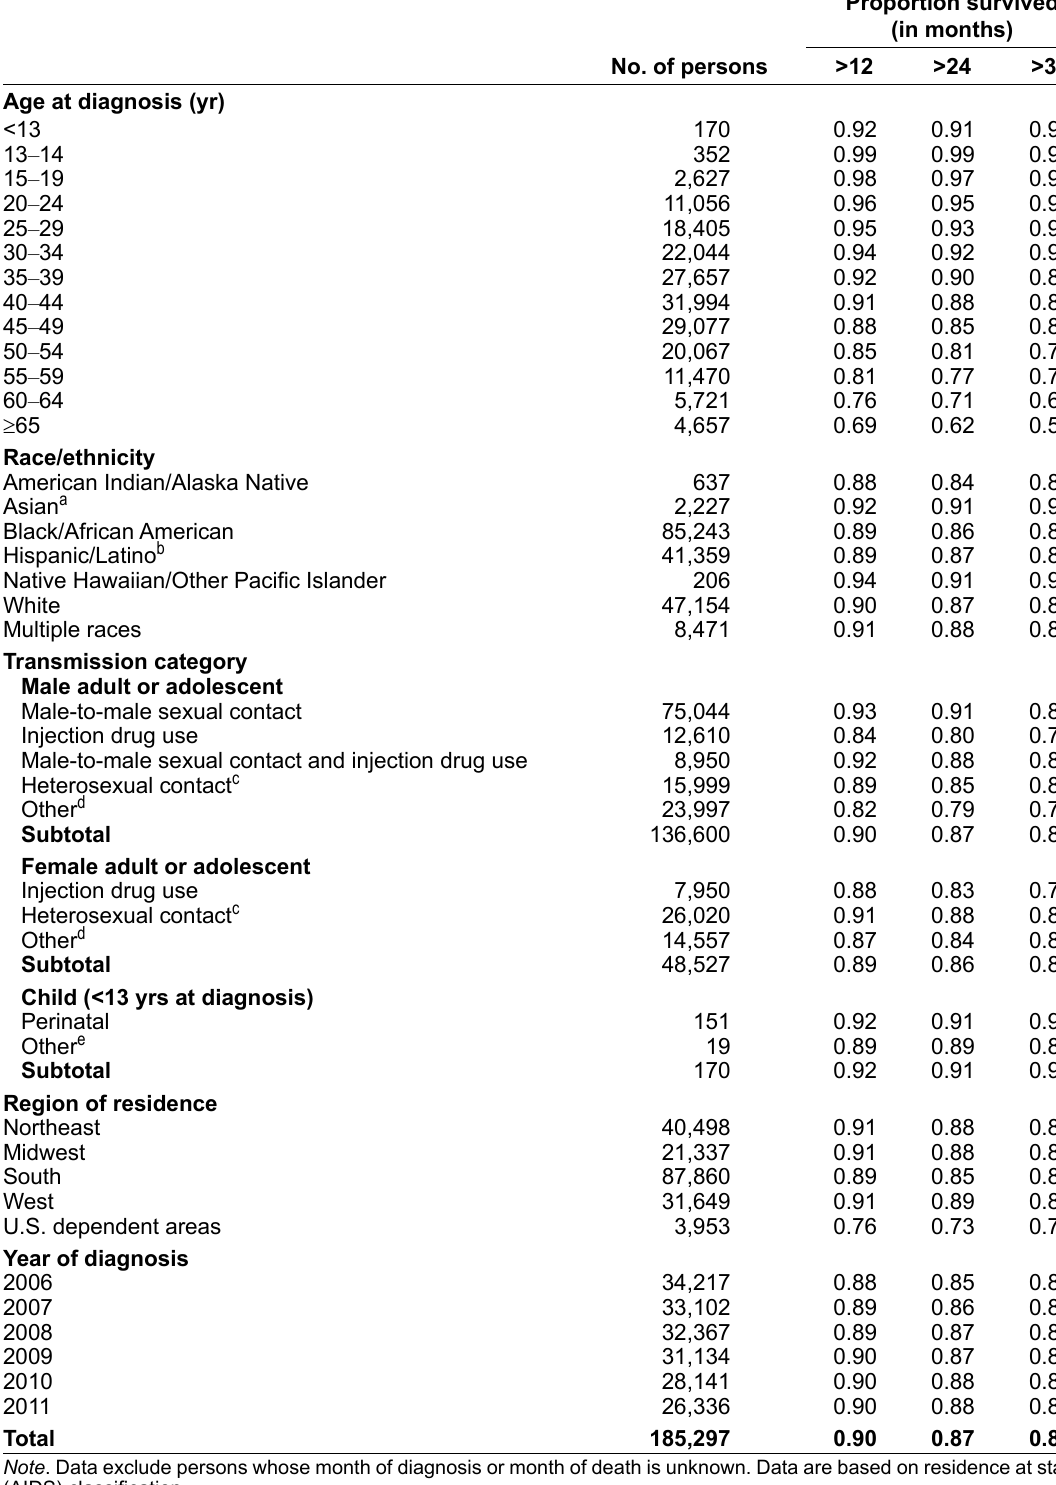
Table 17b. Survival for more than 12, 24, and 36 months after a stage 3 (AIDS) classification during 2006–2011, by selected characteristics—United States and 6 dependent